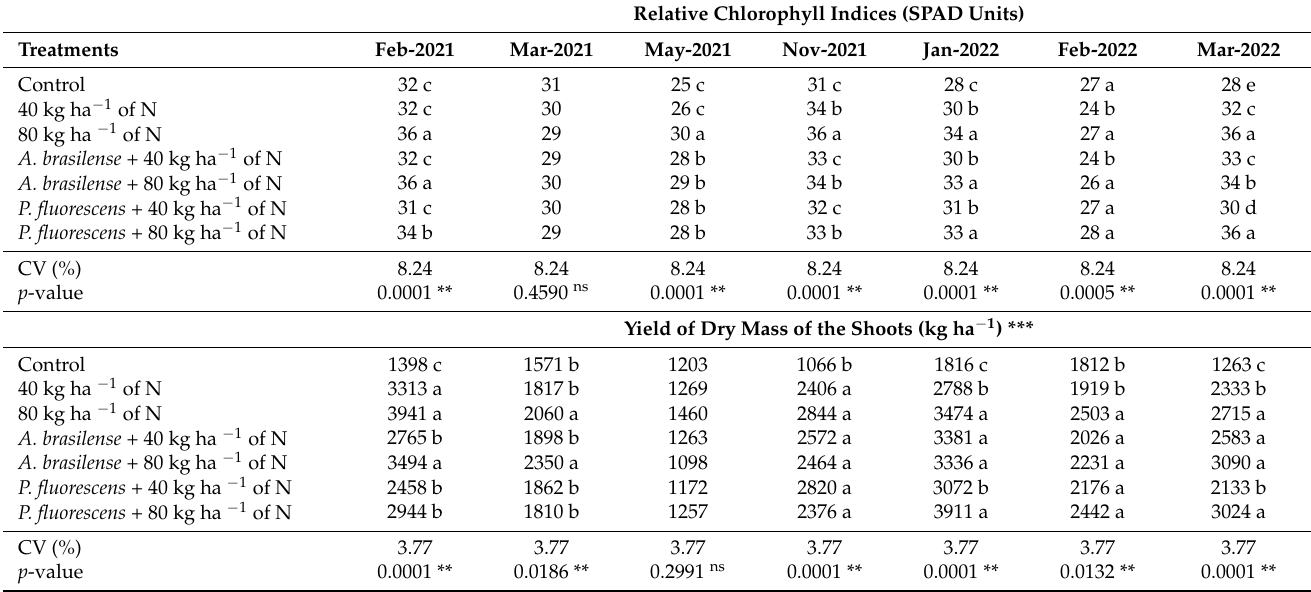
ment with 80 kg ha − 1 N and the inoculated treatment via the foliar spray with A. brasilense Ab-V5 + Ab-V6 plus 80 kg ha − 1 N were statistically higher compared with the others. Table 3. Averages of relative chlorophyll indices and shot dry mass yield of Megathyrsus maximus cv. BRS Zuri inoculated with